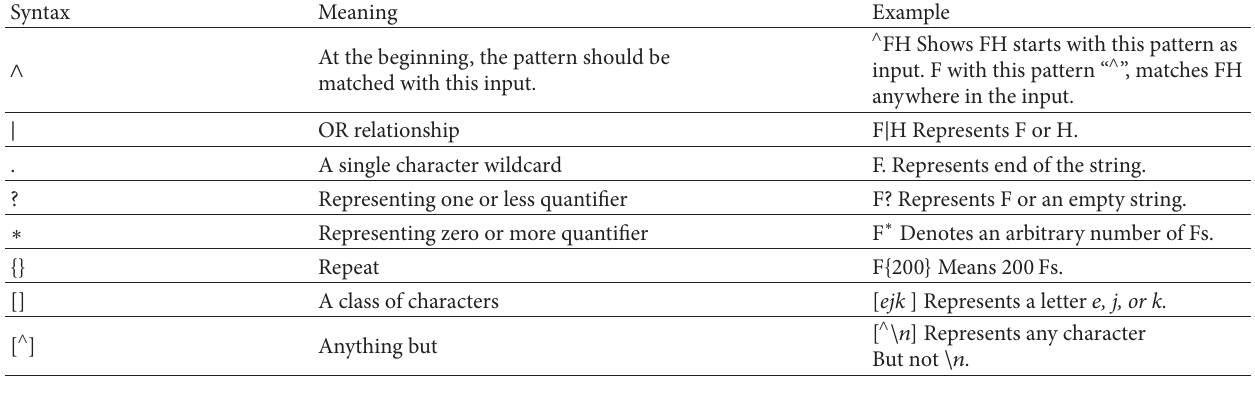
Table 2: Patterns for regular expression.